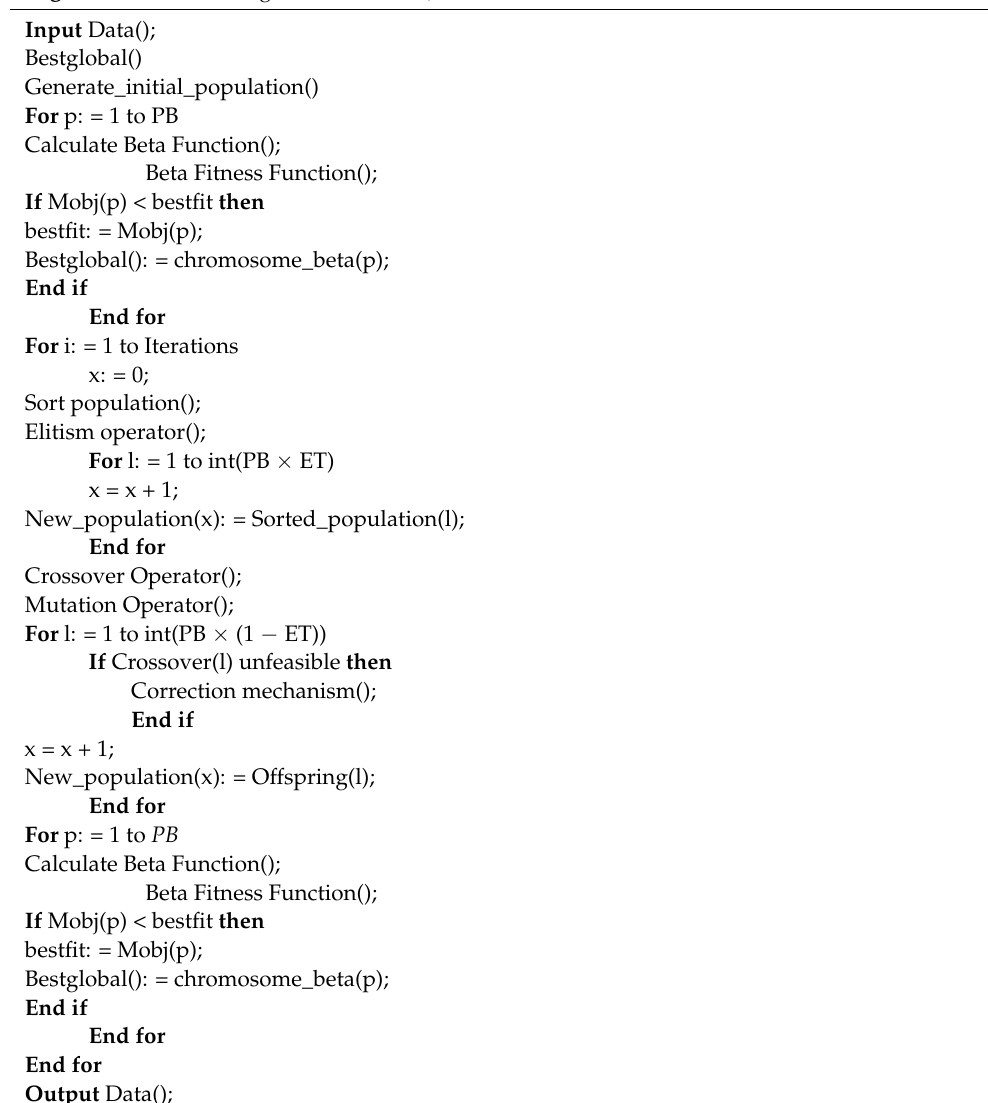
Algorithm 1 Genetic Algorithm for the